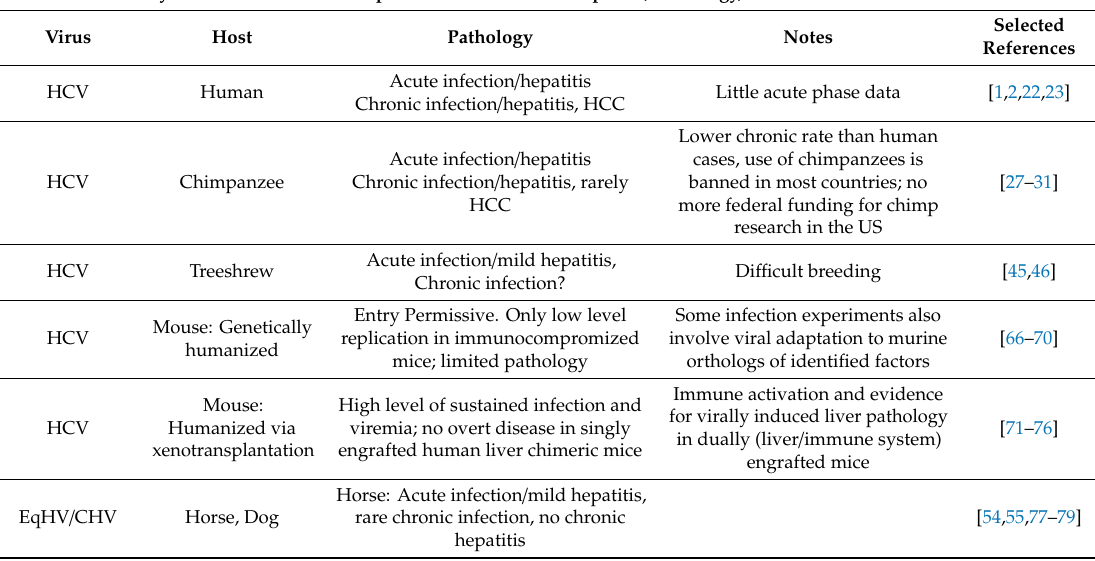
Table1. HepatitisCvirus(HCV)andrelatedhepacivirusinfections, organizedbyspecieswhereinfection is detected. Shaded rows are those being currently used and developed for animal model